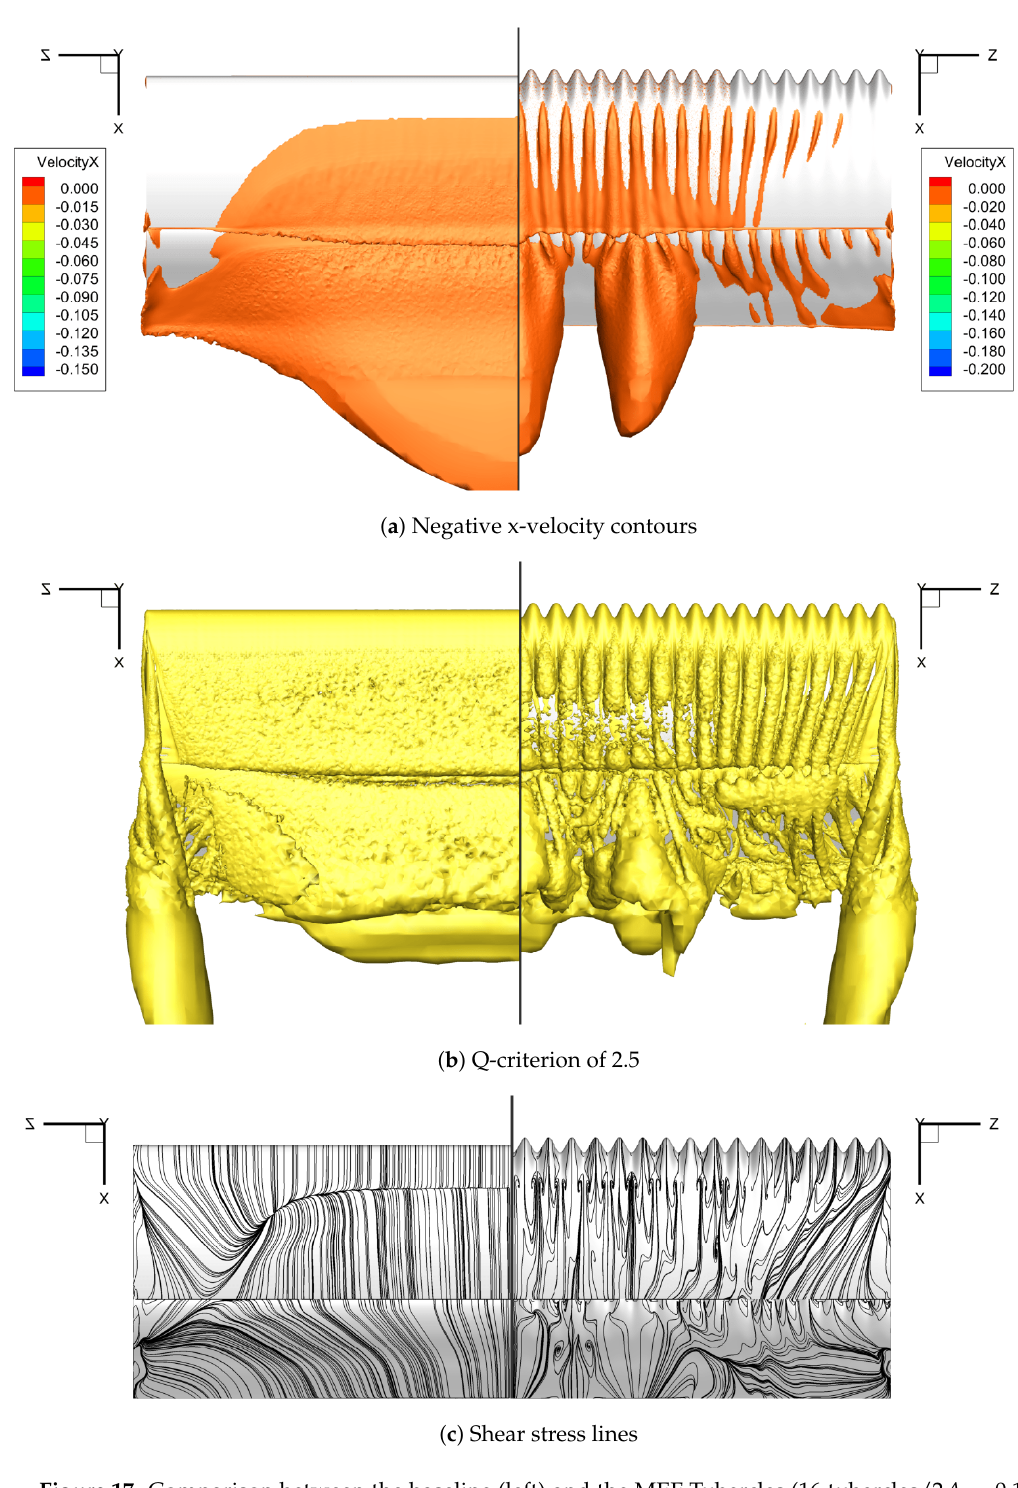
Figure 17. Comparison between the baseline (left) and the MEF Tubercles (16 tubercles/2 A = 0.1 c ) (right) geometries. The geometries are seen from below and slightly from behind. The main element is at the top and the flap at the bottom. The flow is going from the top to the